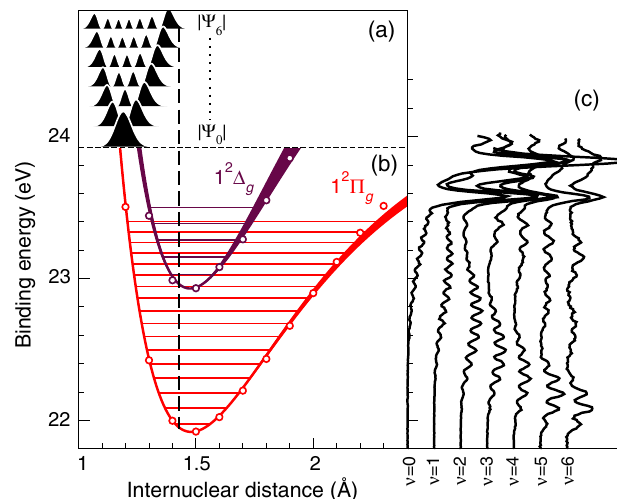
FIG. 10. Illustration of the PEC mapping in the framework of the high-resolution RPE spectroscopy. (a) The seven lowest stationary vibrational wave functions in the core-excited state. (b) Comparison between the reconstructed molecular potentials and 1 2 (cid:5) final ionic states (solid lines) based on the of the 1 2 (cid:2) g g ultrahigh-resolution RPE data and ab initio calculated potentials (open circles). The uncertainty in the reconstructed potential curves is represented by the thickness of the lines. The right turning point of the core-excited wave packet at (cid:3) ¼ 6 is shown by the dashed line. (c) The experimental RPE spectra are presented in relation to the reconstructed